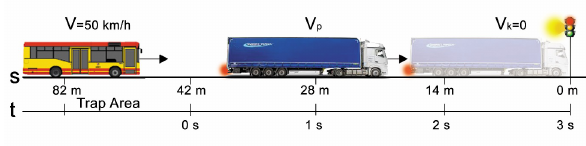
Figure 4: Diagram of the “trap” for a city bus with a yellow signal and a long vehicle in front, stopping in front of the signaling device, V k – final value of the speed of the vehicle